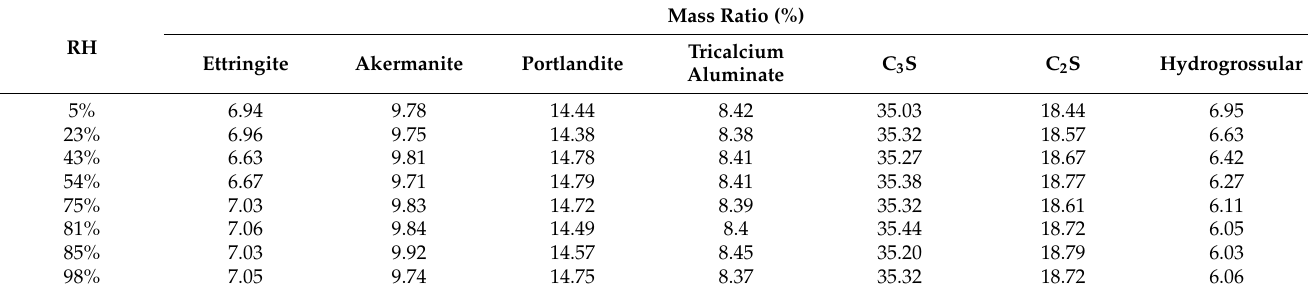
Table 4. Mass ratios of the hydration products of the cured